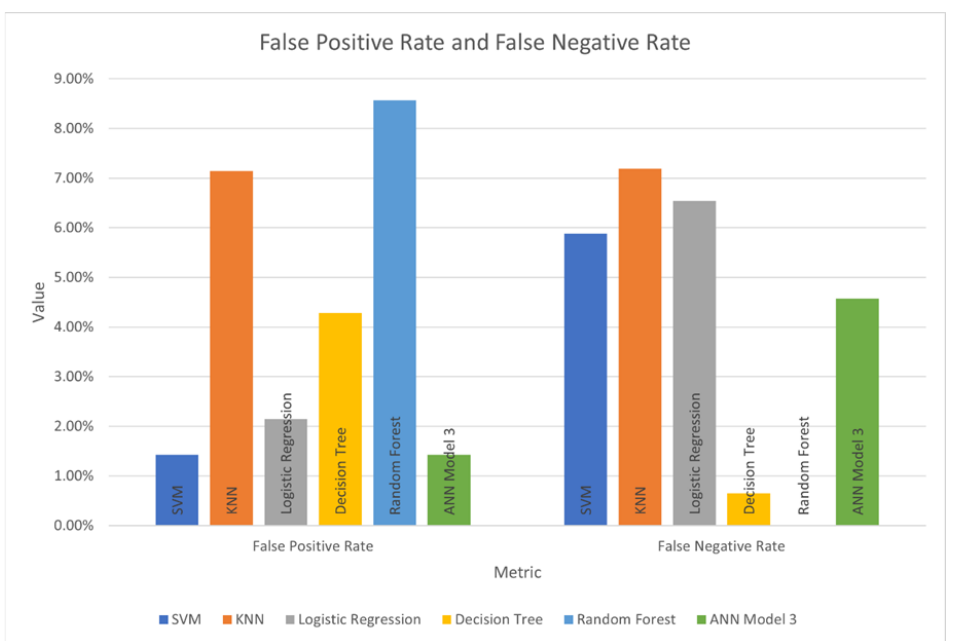
Figure 6. False-positive and false-negative